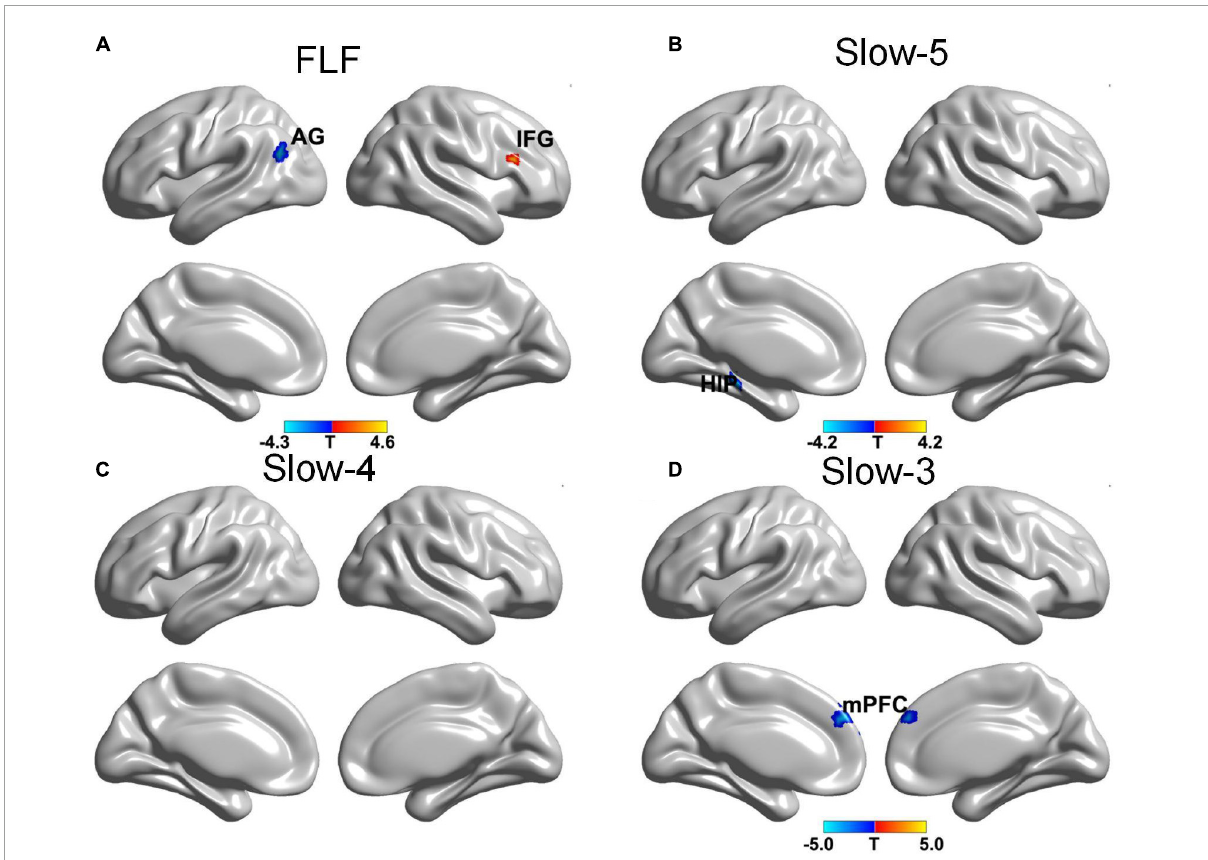
FIGURE2 The gFCD distribution patterns at multiple frequency-bands following sham acupuncture (voxel-level p < 0.005, cluster-level p < 0.05, cluster size > 20 voxels, the small volume corrected and FWE corrected). (A) A decreased gFCD in AG, and an increased gFCD in IFG at FLF; (B) A decreased gFCD in HIP at Slow-5 band; (C) No significant change at Slow-4 band; (D) A decreased gFCD in mPFC at Slow-3 band. gFCD, global functional connectivity density; AG, angular gyrus; IFG, frontal inferior gyrus; HIP, hippocampus; mPFC, medial prefrontal